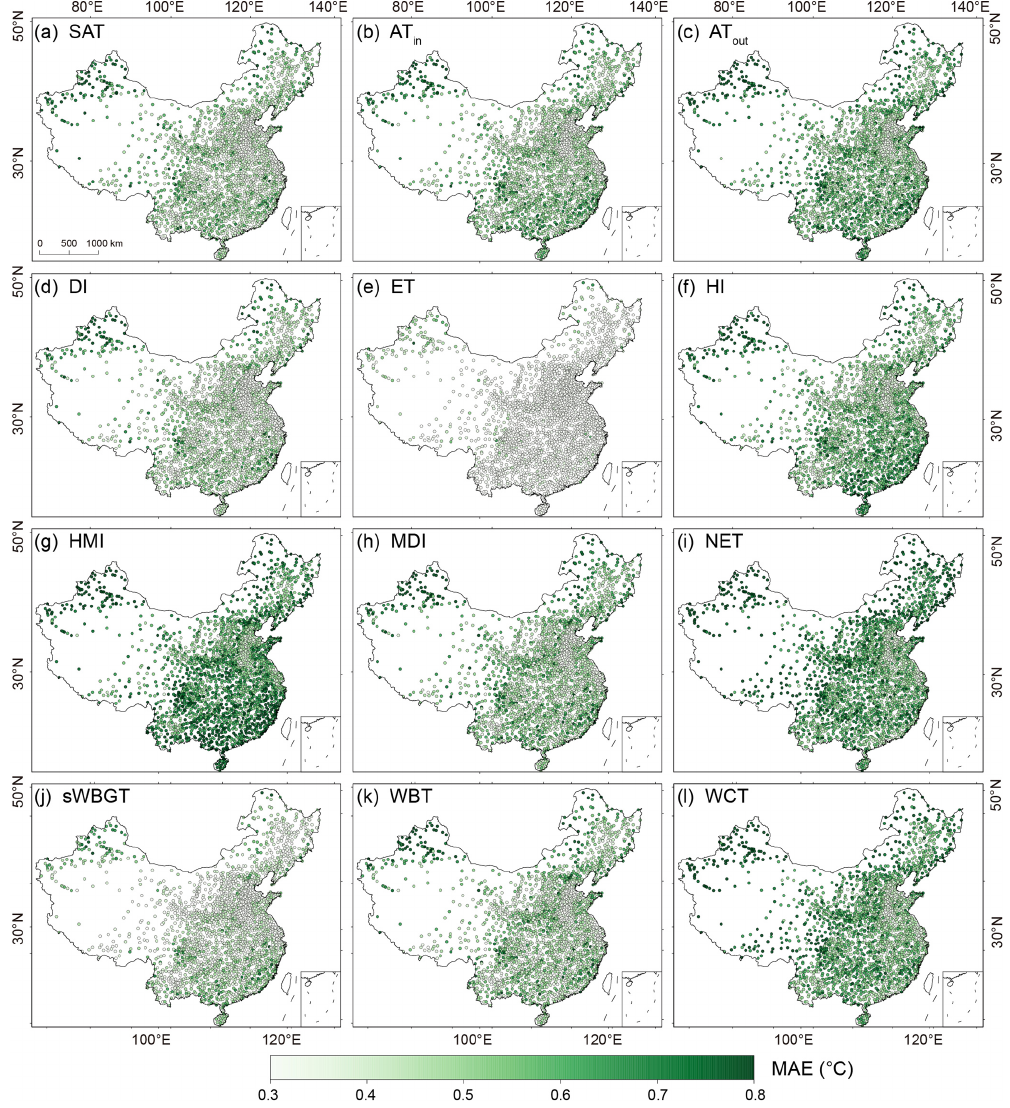
Figure 5. As Fig. 4 but for